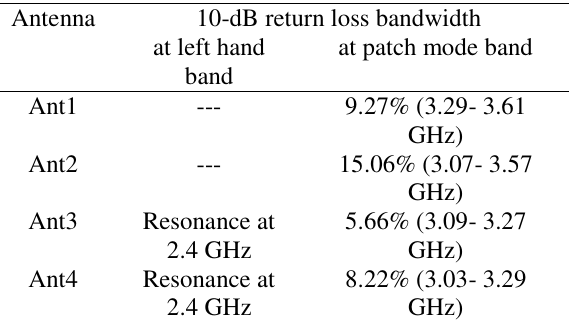
Table 2: Impedance bandwidth of simulated antennas.